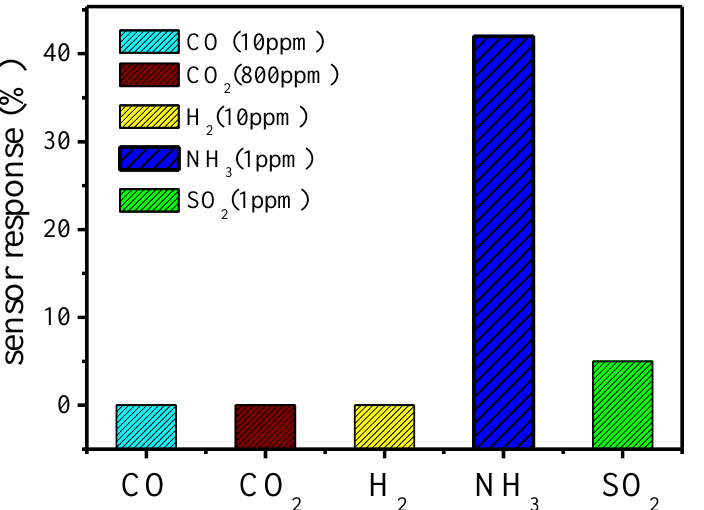
Figure 10. Response to CO, CO 2 , H 2 , NH 3 and SO 2 for a ZnO-NPs/MEMS gas sensor at room tem- perature.